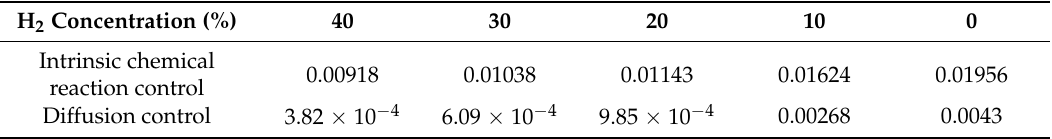
Table 5. Values of gasification rate constant with various concentrations of H 2 at 1273 K. H 2 Concentration (%)